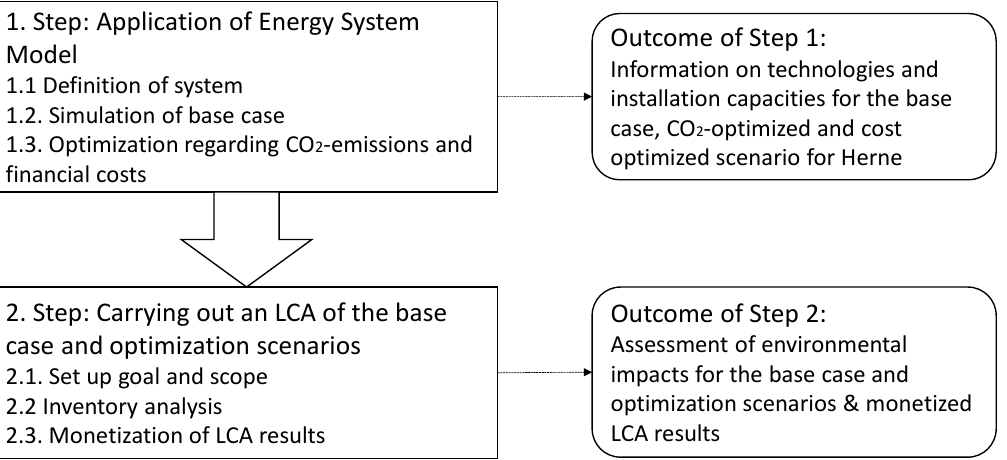
Figure 1. Step 1 and 2 of the integrated LCA, to analyze the power and heat supply for neighborhoods, using the example of the city Herne in Germany for the base case and two optimized scenarios, including the outcomes of the